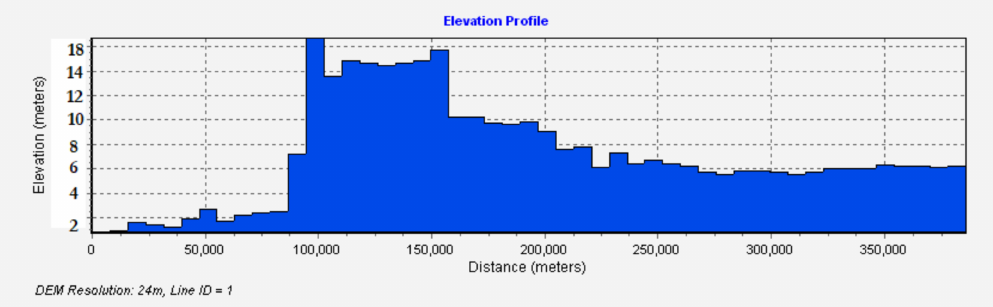
Figure 3. Kribi elevation profile, generated from the Digital Terrain Model